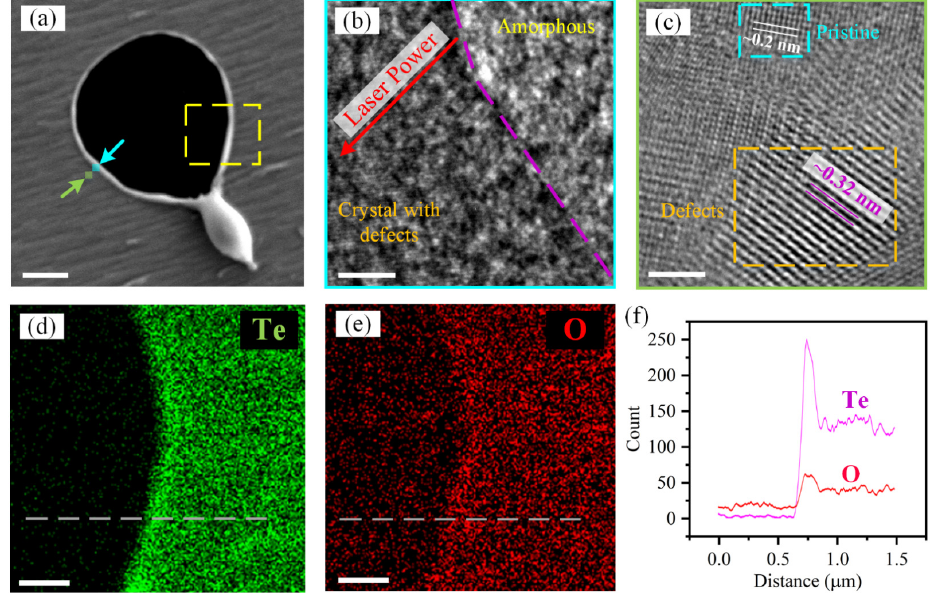
Figure 4. STEM and EDS measurement results of a laser-irradiated Te flake. ( a ) low-magnification image of laser-irradiated Te, scale bar is 1 μ m; variations of atom structure of Te depended on laser power, the measurement locations are shown by the light blue ( b ) and orange ( c ) squares, respectively in the ( a ), scale bar is 2 nm; ESD mapping images of Te ( d ) and O ( e ) elements at the location shown by the gold dash rectangle in the ( a ), scale bar is 500 nm. ( f ) the line-scan EDS at the location shown by the gray dash lines in ( d , e ).